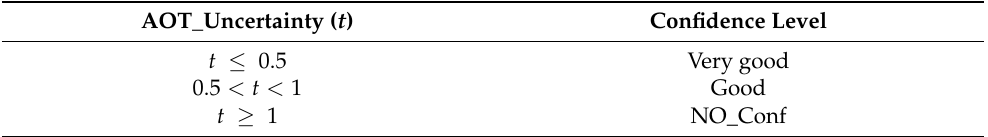
Table 2. Three AOT_uncertainty value ranges correspond to three confidence levels of very good, good, and unreliable.